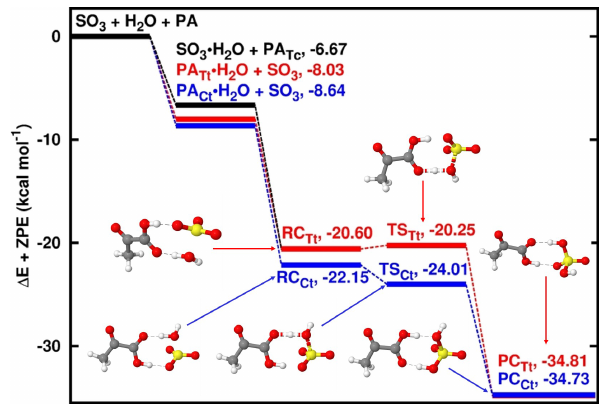
Figure 2. Energy surfaces for the pyruvic-acid-catalyzed SO 3 hy- drolysis. “RC” stands for pre-reactive intermediate; “TS” is transi- tion state and “PC” is product complex. Color coding is yellow for sulfur atom, red for oxygen atom, grey for carbon atom and white for hydrogen atom. Colored lines indicate the different paths in- volving the trans-trans and cis-trans conformers of pyruvic acid. Electronic energy values of all intermediates are indicated, and cor- responding Gibbs free values are given in Table S4 in the Supple-